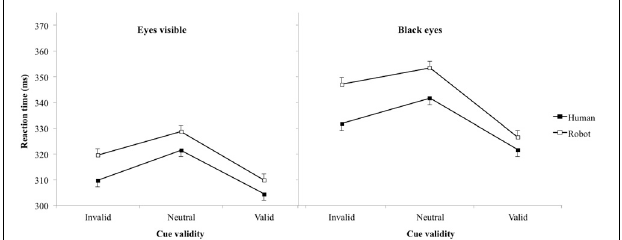
FIGURE 2 | Reaction time (error bar: standard errors of the means) plotted against cue validity for human cue test and robot cue test in experiments 1 (eyes visible) and 2 (blacked-out